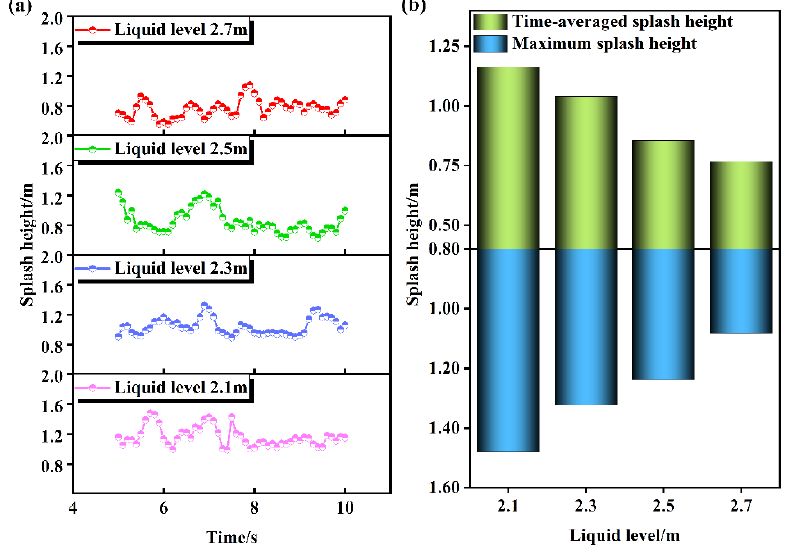
Figure 10. Splash height at different liquid levels ( a ) instantaneous distribution of splash height; ( b ) time-averaged splash height and maximum splash height.